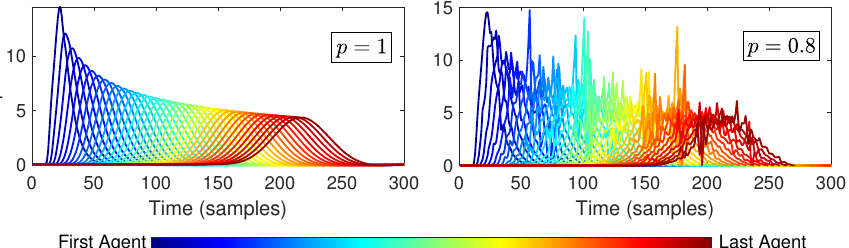
Figure 4. Tracking error for M = 40 vehicle platoon. ( Left ) ideal communication. ( Right ) lossy communication, with a 0.8 probability of successful